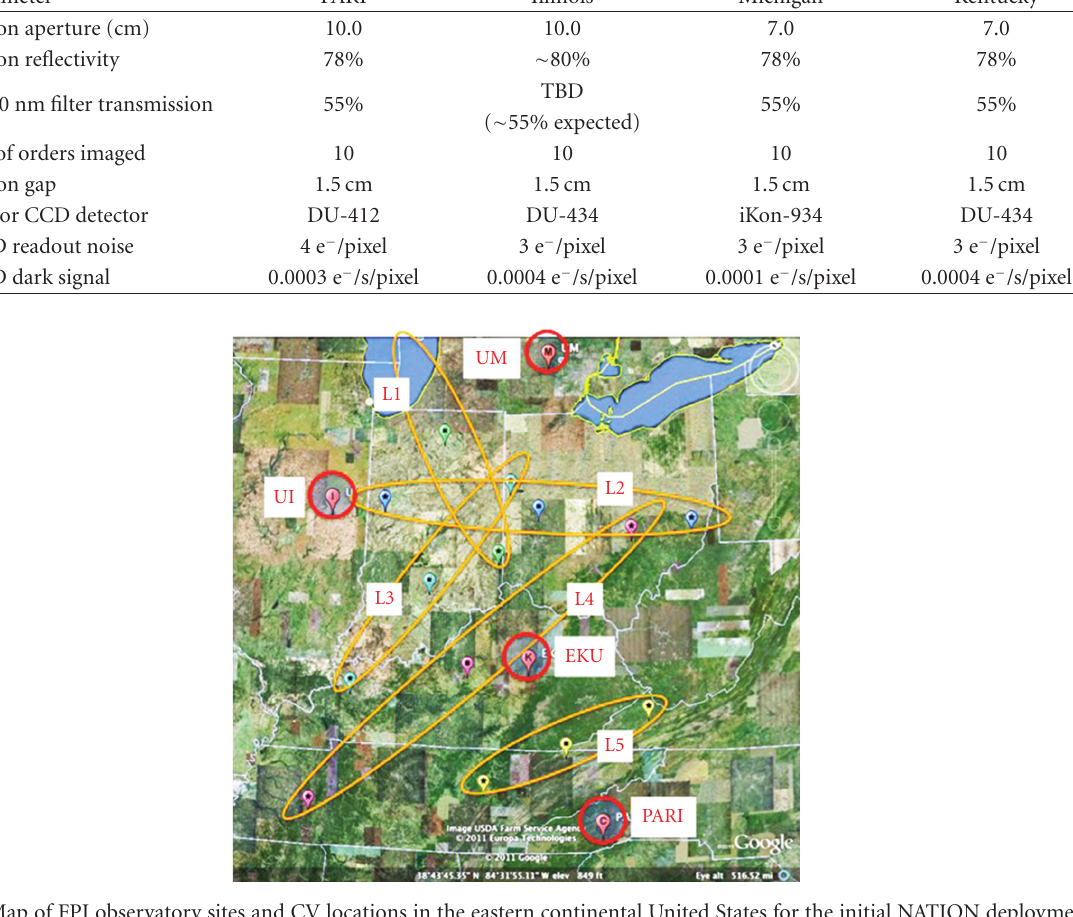
Figure 3: Map of FPI observatory sites and CV locations in the eastern continental United States for the initial NATION deployment. The FPI locations are indicated by markers within the red circles. The five loops (orange) marked L1 through L5 are the five sets of CV locations for pairs of FPI observatories. The loops L1 through L5 represent the pairs of L1 (green markers): UI and UM, L2 (dark blue markers): UM and EKU, L3 (light blue markers): UI and EKU, L4 (orange markers): UI and PARI, L5 (yellow markers), PARI and